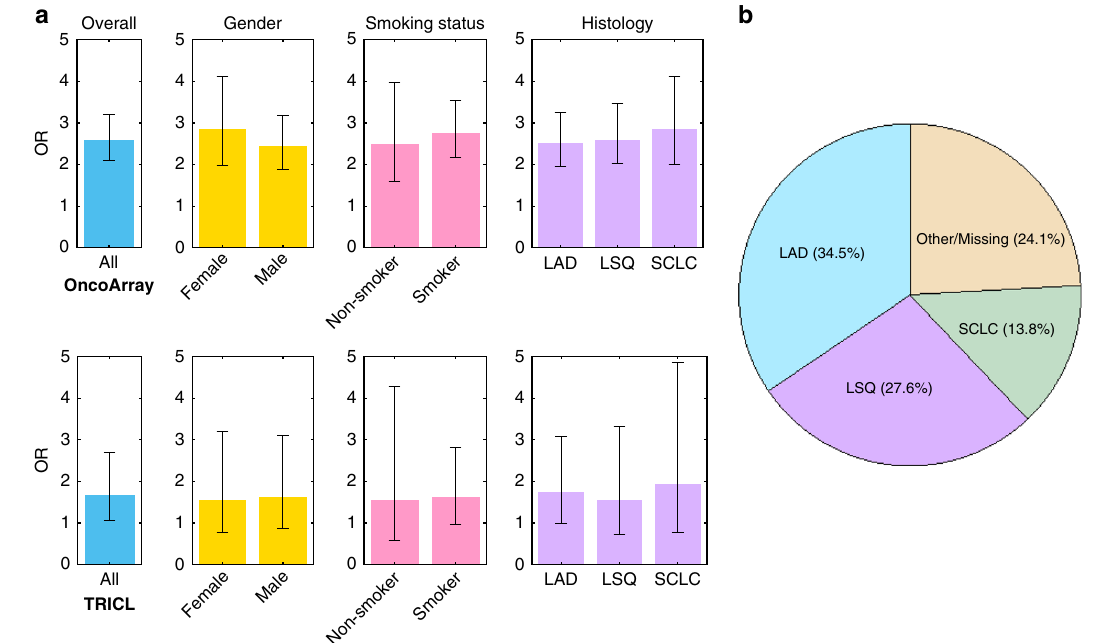
Fig. 3 KIAA0930 rs150665432 association with lung cancer risk. a Strati fi ed analyses of the association between KIAA0930 Q4X and lung cancer risk, shown by different colors. Compared to non-carriers, Q4X carriers had a signi fi cantly increased lung cancer risk with ORs being 2.59 in the discovery ( P = 1.15 × 10 − 18 , n = 27966) and 1.69 in the replication datasets ( P = 0.03, n = 10248). Strati fi ed analysis showed that Q4X carriers had an increased, consistent risk for lung cancer among females, males, smokers and non-smokers and consistent in histological subtypes. The error bars are OR ± the 95% CI values. P values were determined by logistic regression analysis adjusted by age, gender, smoking status and the principal components. Source data are provided as a Source Data fi le. b Distribution of KIAA0930 Q4X homozygotes. In the discovery data, all homozygotes of the mutated allele in rs150665432 were developed to lung cancer in the discovery data. Source data are provided as a Source Data fi le (Source Data 1, 2, and 3). Color shades indicate the histological (Fig. 5a). The Genotype-Tissue Expression (GTEx) project (Sup-